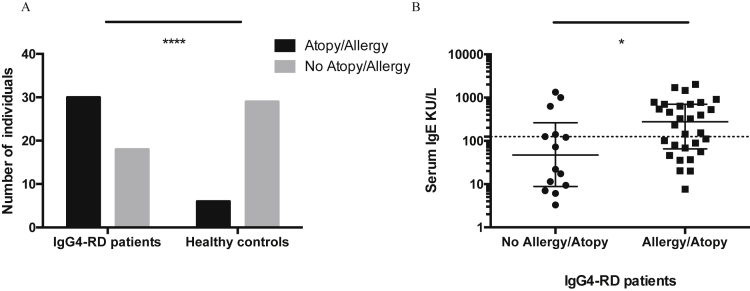
Allergy and/or atopy and serum IgE levels in IgG4-RD patients and healthy control subjects. (A) Bar chart showing the number of IgG4-RD patients and healthy control subjects with (black) or without (grey) a history of allergy and/or atopy. (B) Dot plot showing serum IgE concentration (kIU/L) in IgG4-RD patients with and without a history of allergy and/or atopy. Dashed line is the serum IgE upper limit of normal (≥125 kIU/L). Mann-Whitney P values, where *P < .05, ****P < .0001.